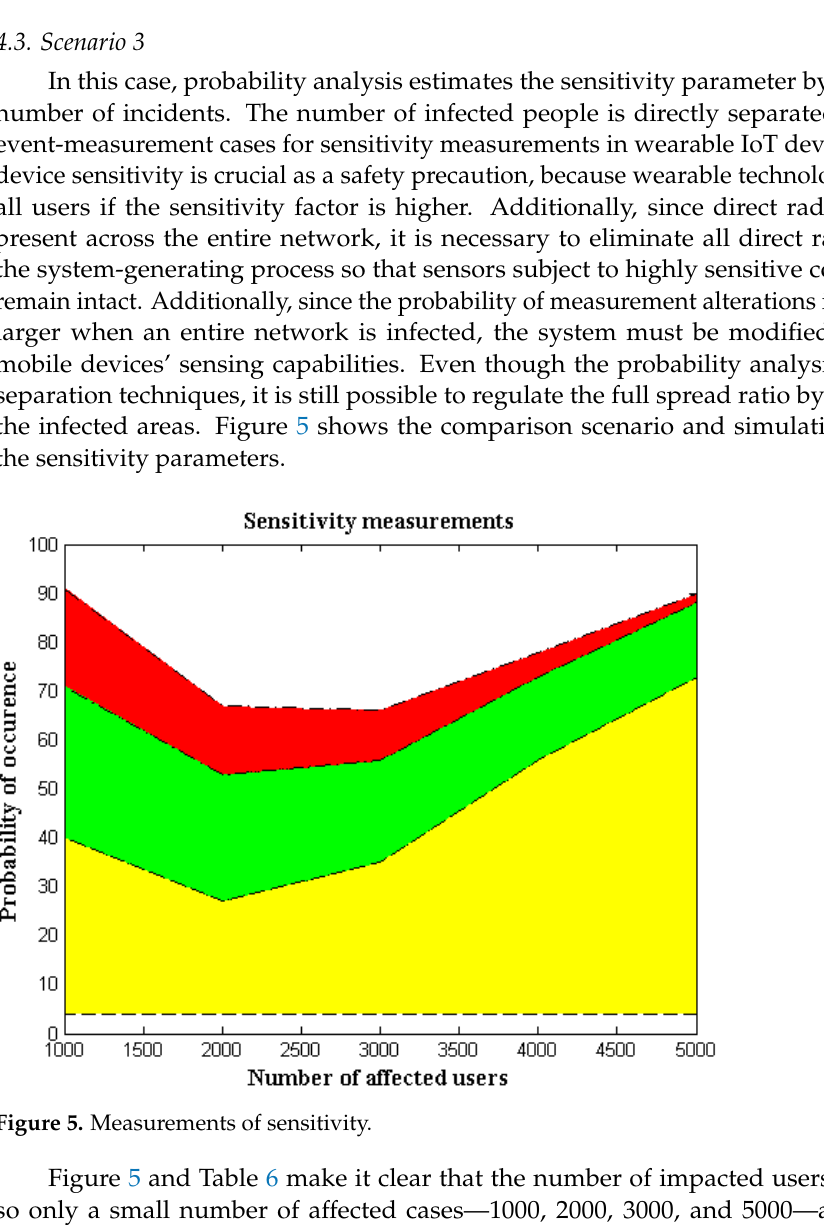
Table 6. Percentage of sensitivity.